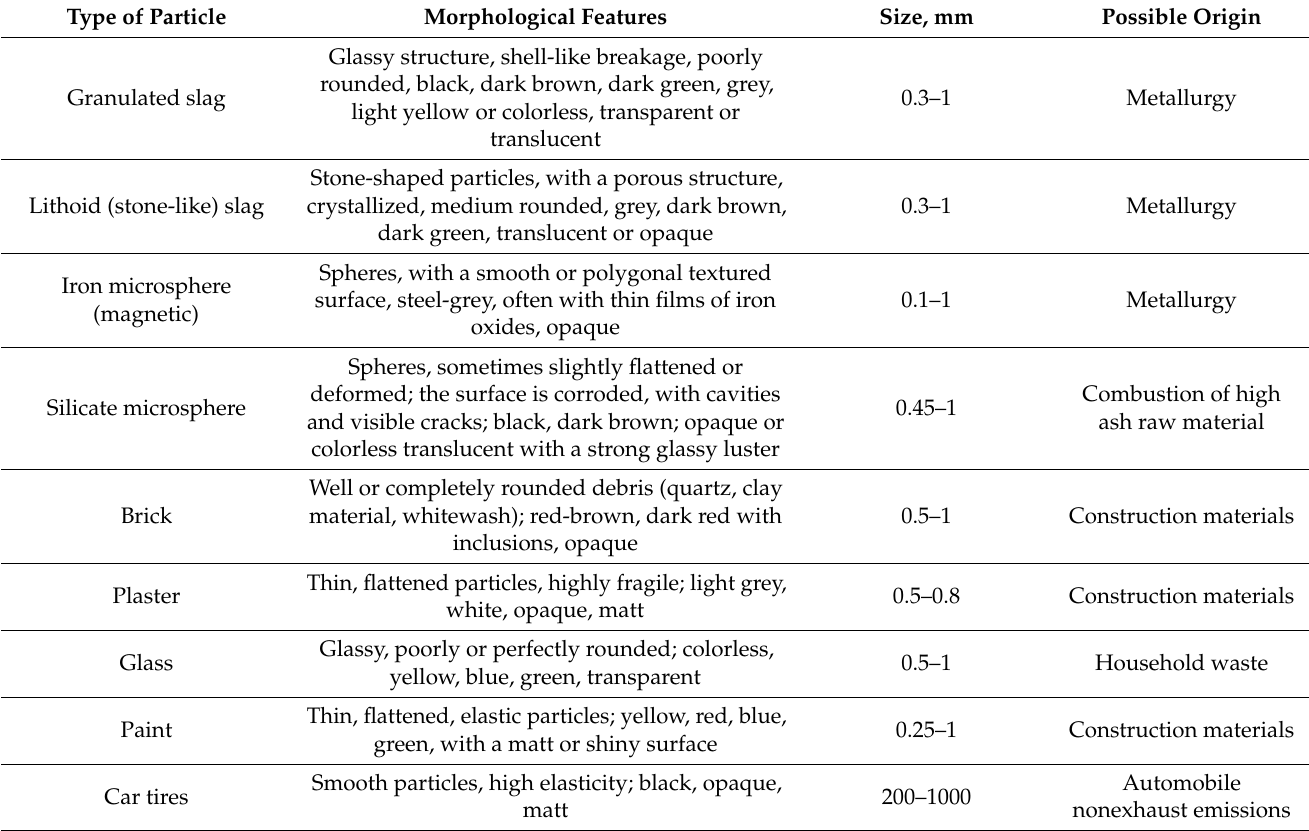
Table 6. Morphological features of types of technogenic particles in the studied